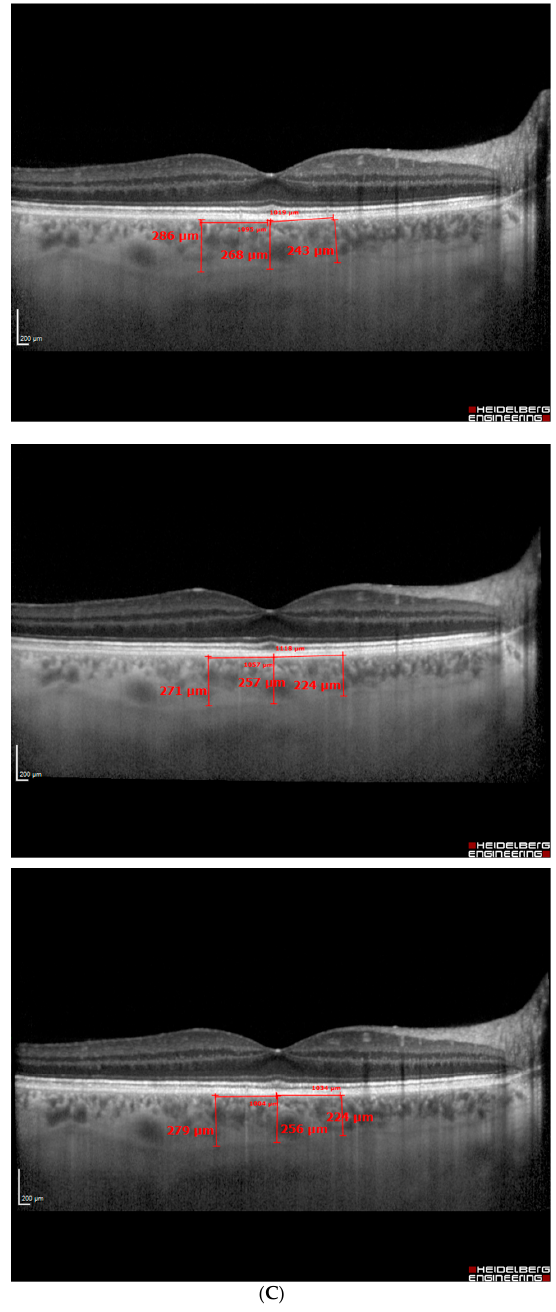
Figure 2. ( A – C ) A 54-year-old man with an apnea hypopnea index (AHI) of 54.8/h received nasal continuous positive airway pressure (CPAP) treatment starting 2 October 2013. Peripapillary retinal nerve fiber layer (pRNFL), total retinal (TR), and choroidal thickness measurements were taken on 1 October 2013 (baseline), on 14 January 2013 (after 3 months of CPAP) and on 2 October 2014 (after 12 months of CPAP). Following CPAP, AHI decreased to 6.1/h. ( A ) pRNFL thickness in the right eye (top: baseline, bottom: global RNFL thickness over 3 visits). Note the overall increasing trend of the curve. ( B ) TR thickness 12 months after CPAP treatment vs. baseline. Note the retinal thickening in the last EDTRS subfield. ( C ) Choroidal thickness in the right eye at the levels temporal, subfoveal, and nasal (top: baseline, middle: after 3 months of CPAP, bottom: after 12 months of